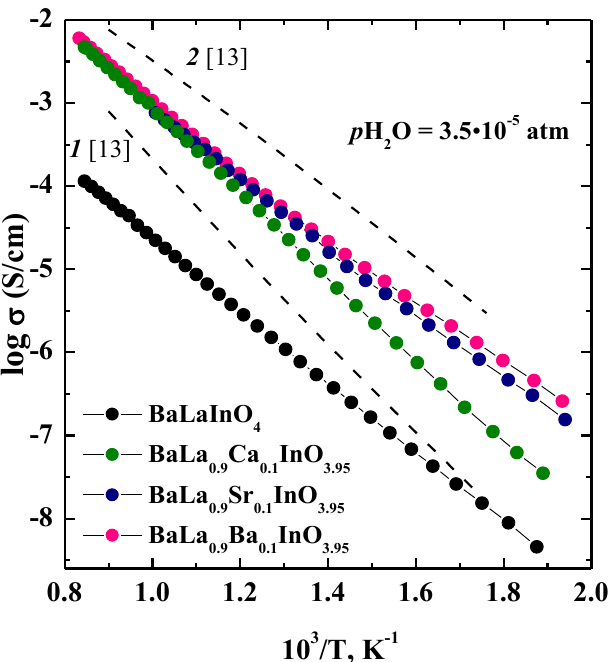
Figure 5. The temperature dependencies of the total conductivities ( p O 2 = 0.21 atm) of BaLaInO 4 and BaLa 0.9 M 0.1 InO 3.95 (M = Ca 2+ , Sr 2+ , and Ba 2+ ) in dry air and comparison with ( 1 ) BaNdInO 4 and ( 2 ) Ba 1.1 Nd 0.9 InO 3.95 in air.